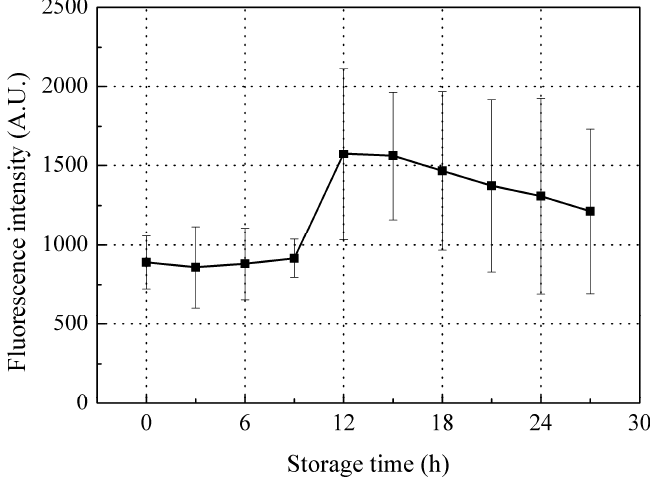
Figure 6. Changes in peak B fluorescence intensity during storage. Values shown are the means of 9 replicates with standard deviation bars.